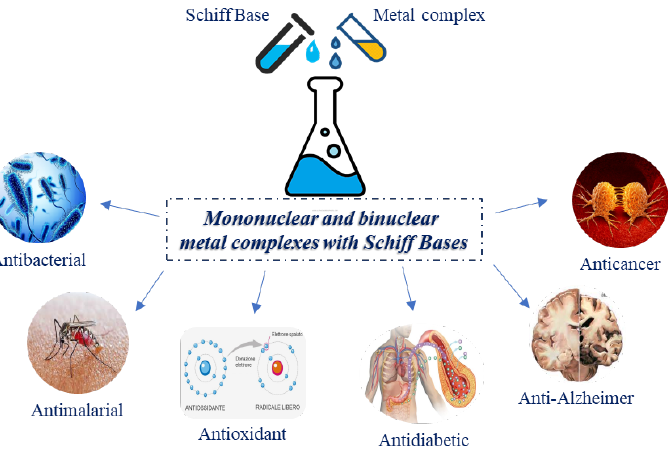
Figure 1. Multiple activities of mononuclear and binuclear metal complexes with Schiff